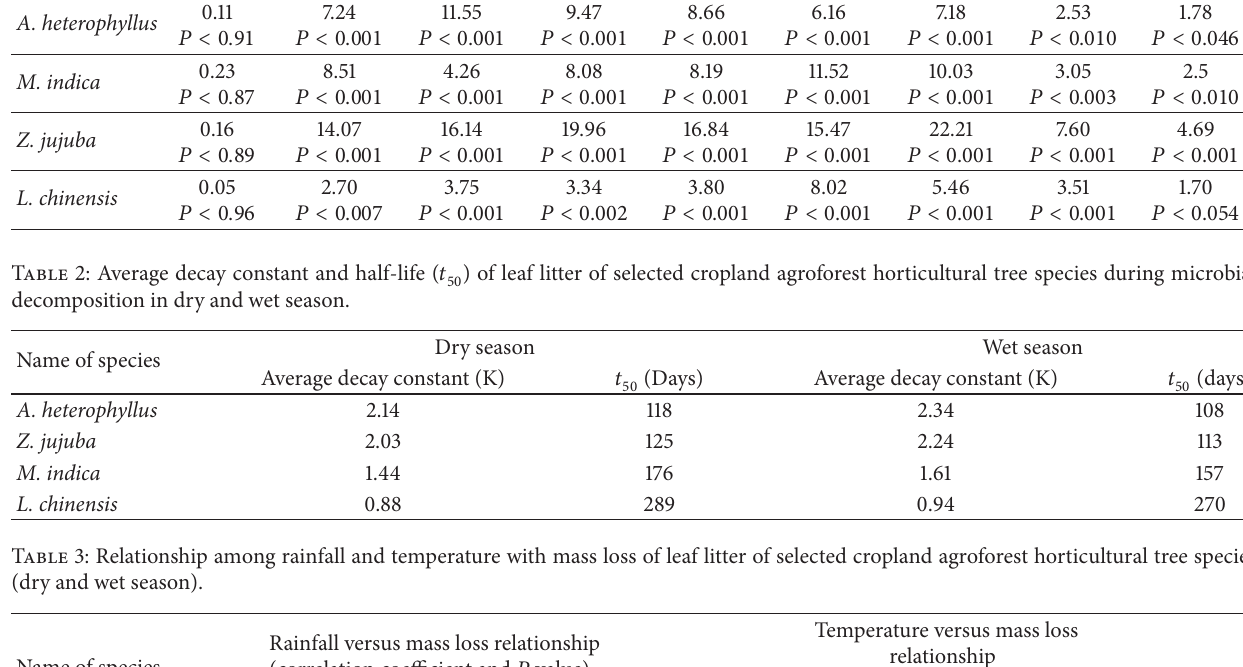
Table 1: Significant test of mass loss of leaf litter of the selected cropland agroforest horticultural tree species among dry and wet season. Name of species 00 days